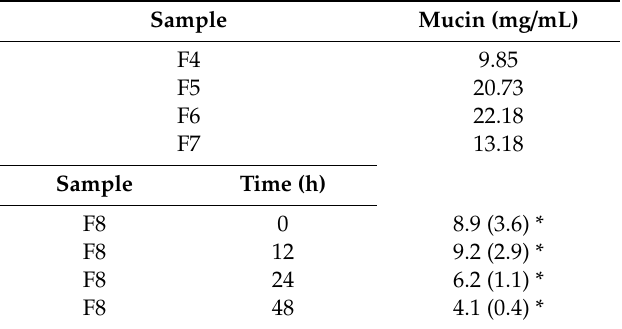
Table 2. Mucin concentration estimated in the skin–mucus